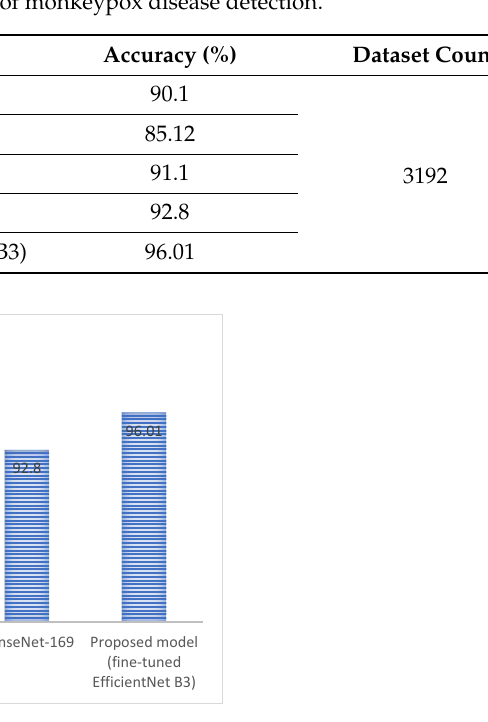
Figure 14. Analysis of Recall value for the deep learning algorithms. Table 7. Recall calculation for detection of monkeypox disease detection.